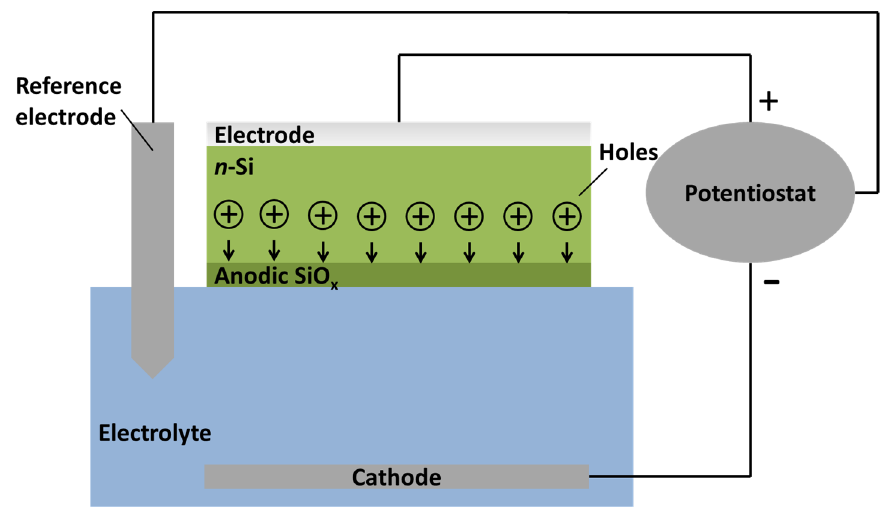
Figure 1. Schematic diagram showing the field-induced anodisation (FIA) process.